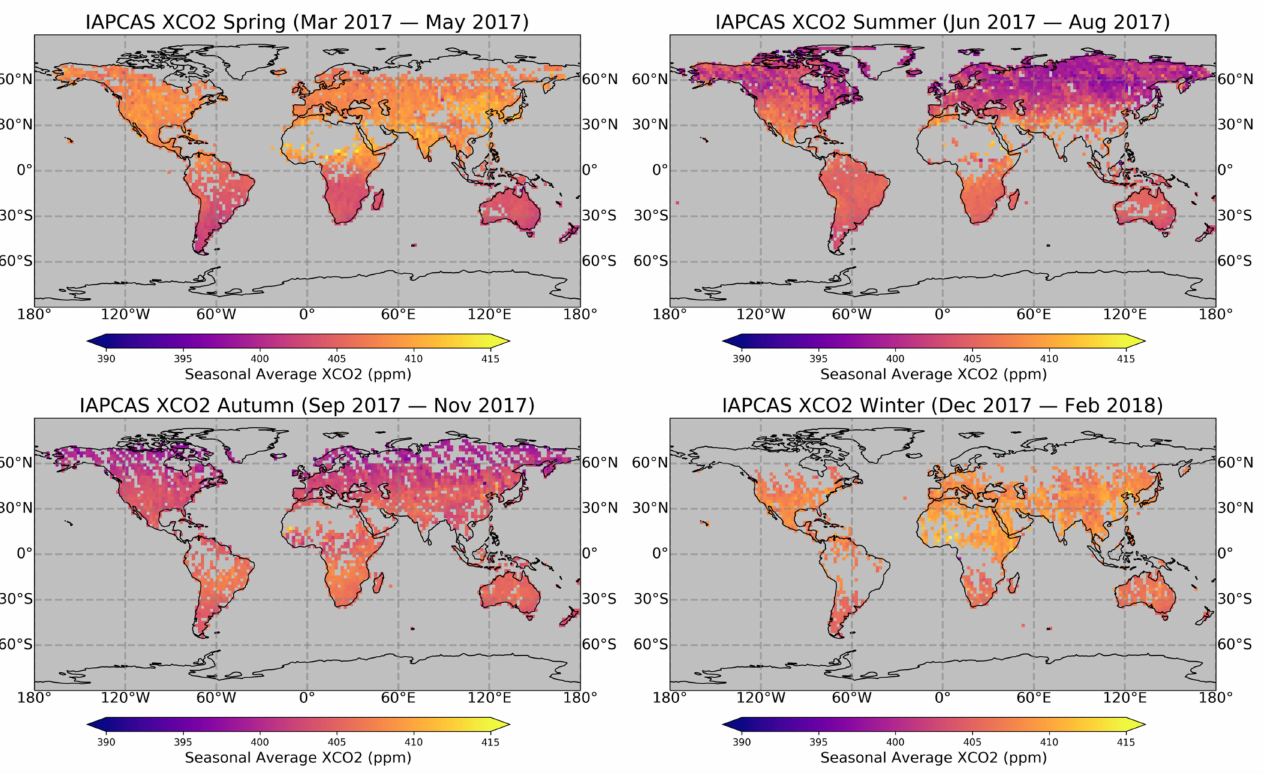
Figure 1. Seasonal maps of the IAPCAS TanSat v2